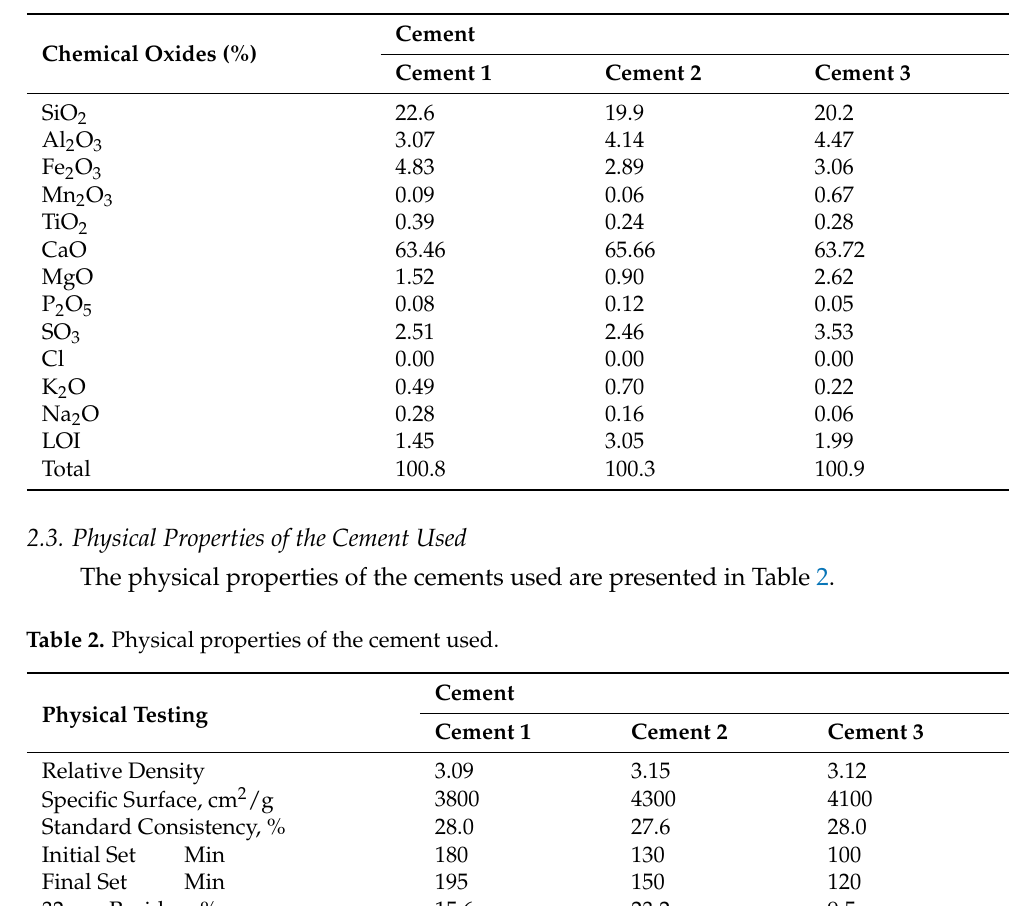
Table 1. Chemical Analysis of the cements used.